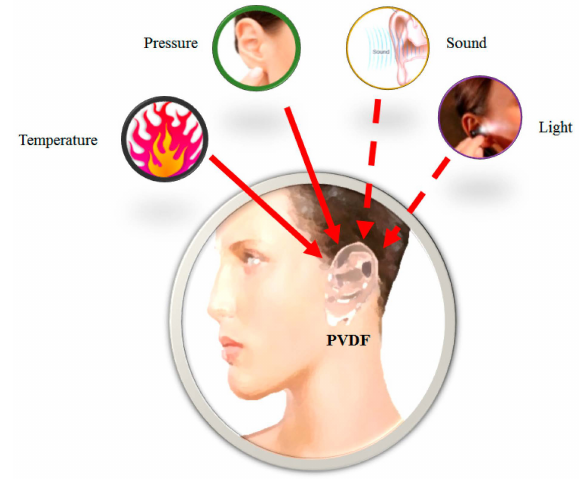
Figure 1. Diagram of the different stimuli applied to the PVDF prosthesis.